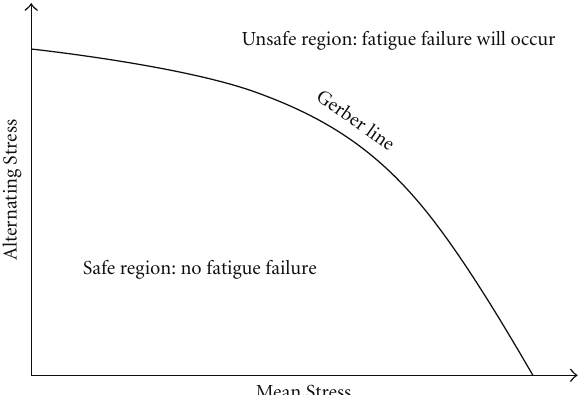
Figure 7: The curve of best fit through material test data is the Gerber